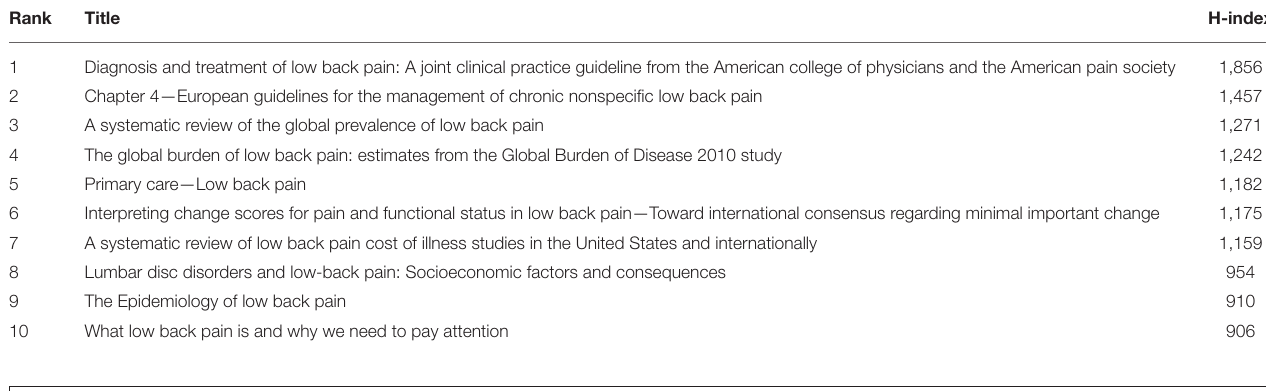
TABLE 2 | Top 10 cited articles related to low back pain (LBP).